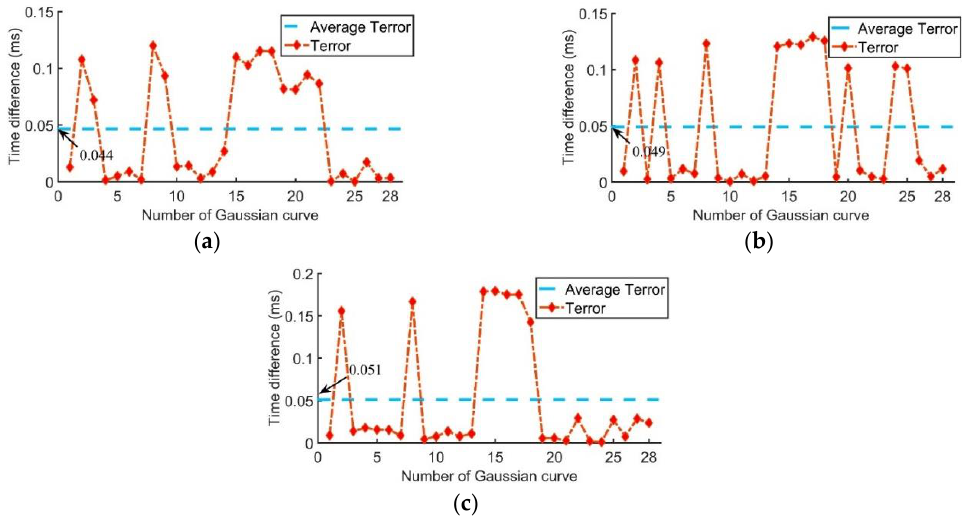
Figure 15. Terror with different sensor network schemes: ( a ) type 1 sensor network; ( b ) type 2 sensor network; ( c ) type 3 sensor network.